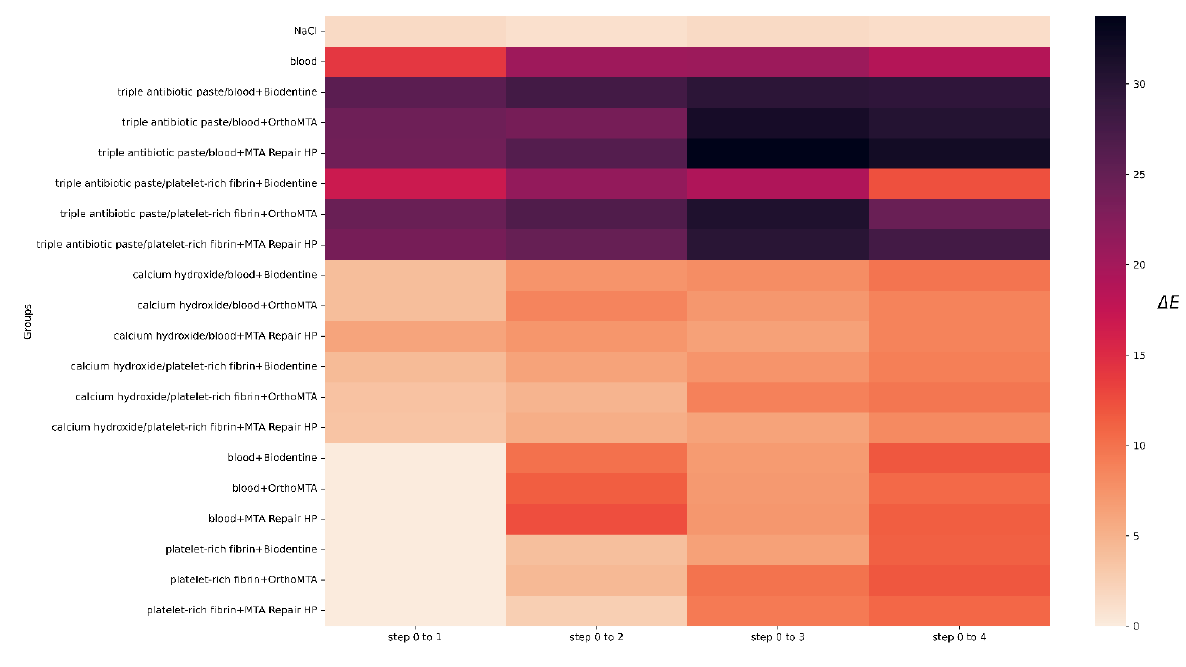
Figure 4. Values of ∆E for all groups and steps.